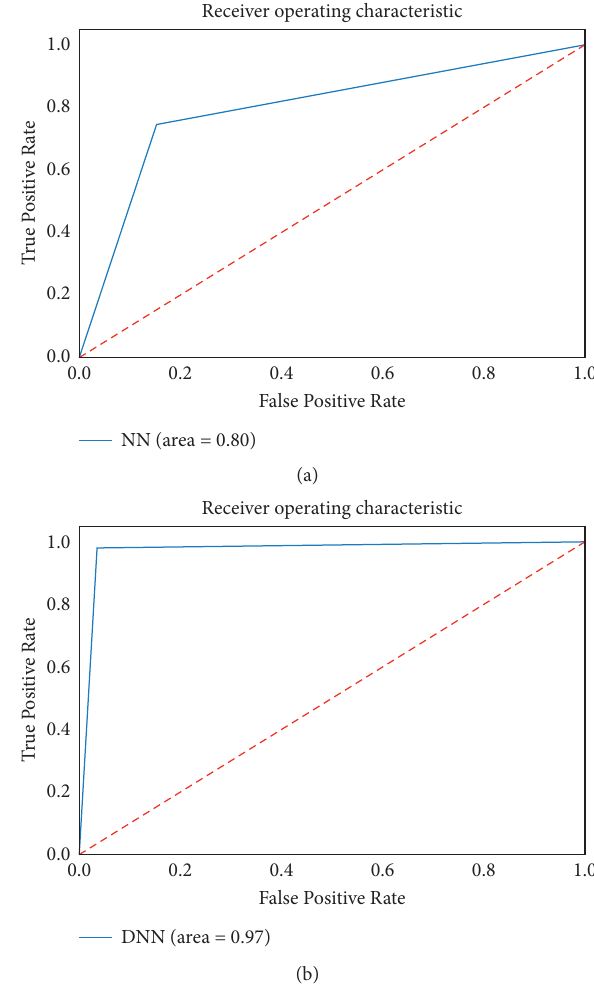
Figure 6: ROC of the test dataset computed in (a) Shallow Neural Network and (b) Deep Neural